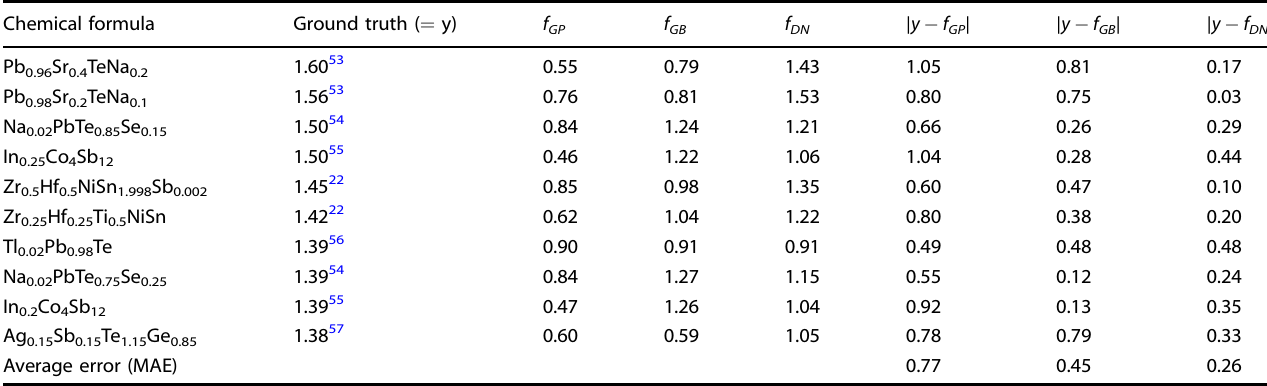
Table 2. Predicted ZTs of the machine learning algorithms for top 10 high-ZT materials in the MRL dataset. Chemical formula Ground truth ( =